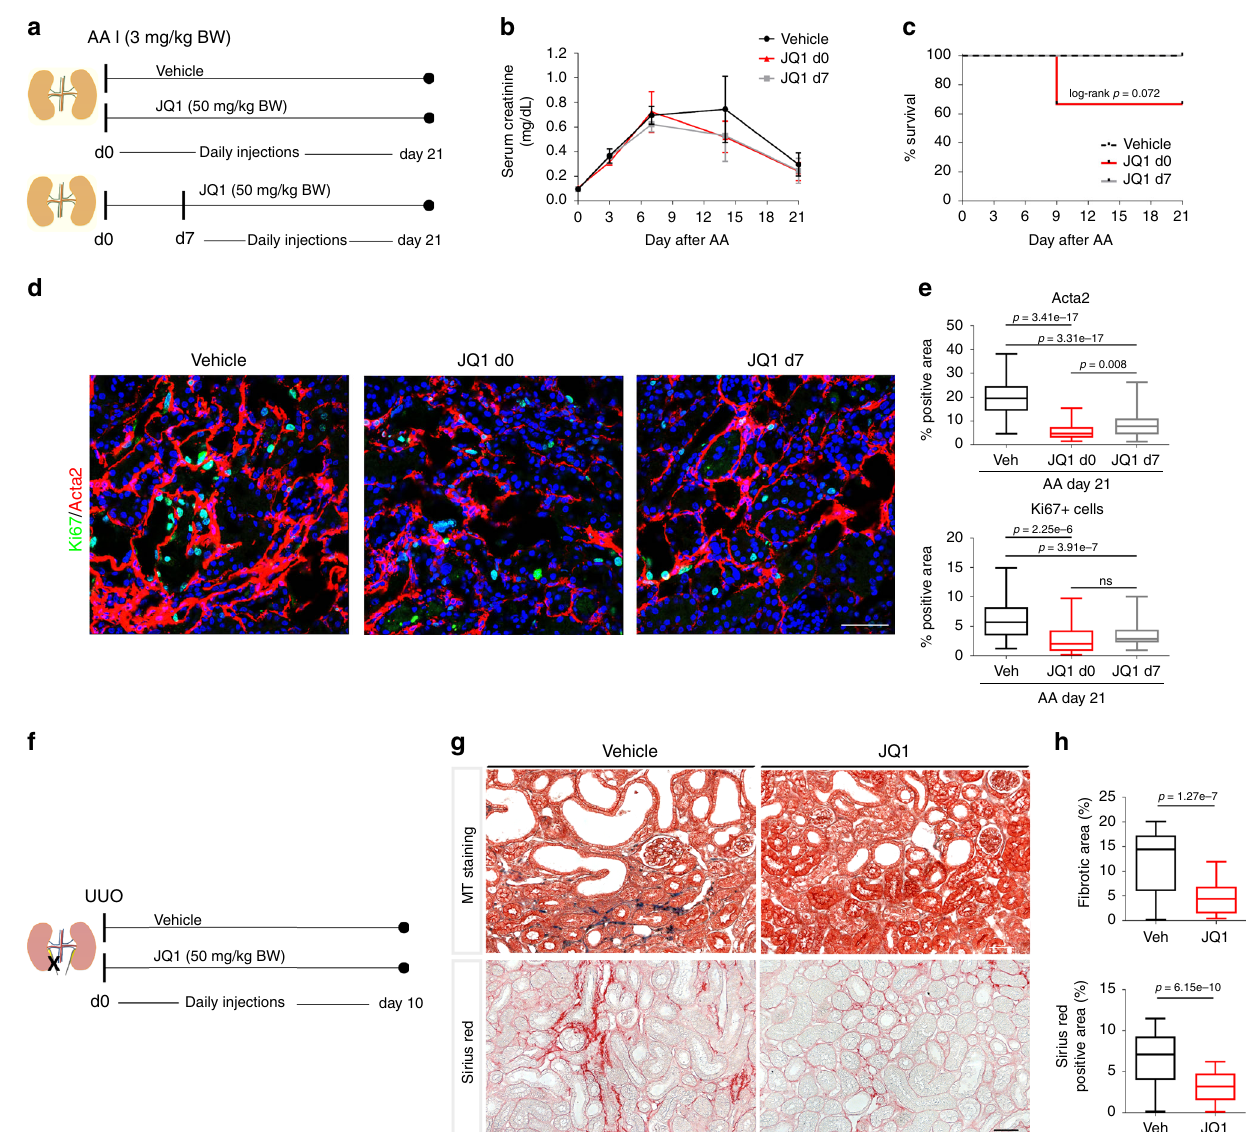
Fig. 7 BET inhibition blocks fi brosis development in AAN and UUO. a BALB/c mice (10- to 12-week-old males) were treated daily with JQ1 (50 mg/kg) or vehicle (DMSO/10% ß-cyclo dextrin 1:10) starting on the day of aristolochic acid (AA) injection (3 mg/kg BW) or day 7 after AA injection. Mice were sacri fi ced on day 21 after AA injection. b Serum creatinine (mg/dL) trajectories of vehicle and JQ1 treated mice from day 0 until day 21 after AA (mean ± SD). vehicle: n = 7; JQ1 d0: n = 6; JQ1 d7: n = 8 biologically independent samples. c Survival curves after AA injection: 100% survial in vehicle and JQ1 d7 group, 67% survival in mice treated with JQ1 from day 0 until day 21 after AA injection. d Representative Ki67-1/Acta2-immunostained AAN kidneys treated with vehicle or JQ1 d0 or JQ1 d7. e Quanti fi cation of α -SMA + (Acta2) surface area. Percentage of Ki67 + cells (Ki67 + cells/total number of cells (DAPI) per hpf). vehicle: n = 7 (60 hpf); JQ1 d0: n = 4 (33 hpf); JQ1 d7: n = 8 (64 hpf) at least 8 hpf per sample. f C57BL/6N mice (8- to 10-week-old males) were treated daily starting at the day of UUO surgery with JQ1 (50 mg/kg) or vehicle, and were sacri fi ced on day 10 after surgery. g Representative trichrome-stained and Sirius-red stained sections. h Quanti fi cation of fi brotic area (masson trichrome + -stained) ( n = 7, 5 hpf per sample) and Sirius red